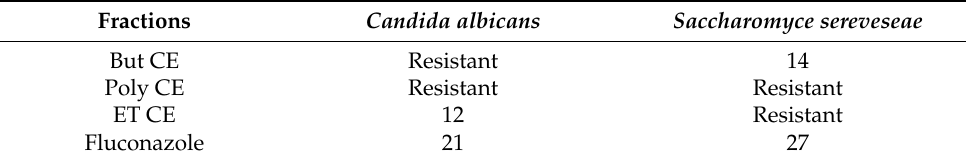
Table 8. Inhibition diameter of C. europaea fractions against yeasts in (mm).